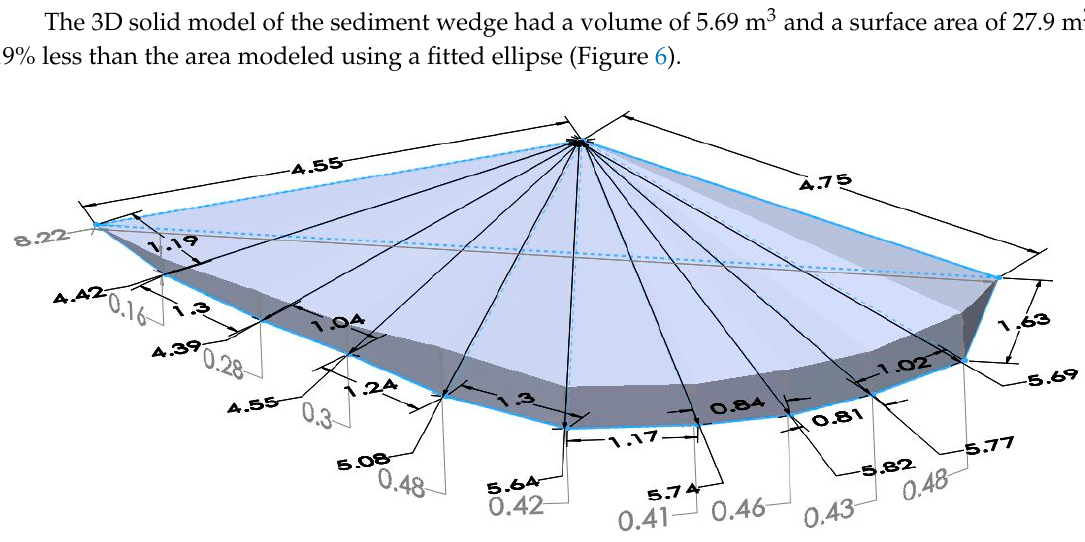
Figure 6. 3D solid model created in SolidWorks 2016.